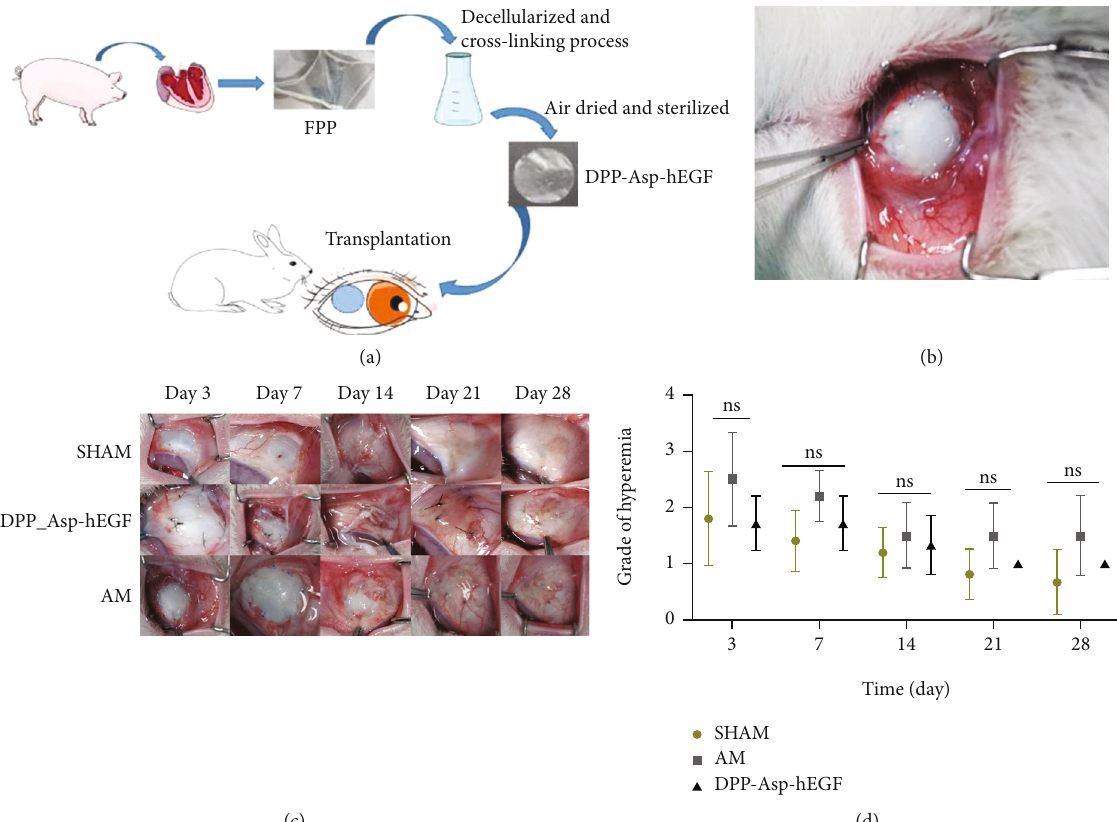
Figure 5: Clinical fi ndings in rabbit conjunctival defect model. The surgical procedure (a). Sca ff old transplantation on the day of surgery (b). Gross views of clinical signs at di ff erent points in time (c). A line graph showing the variation in the grade of hyperemia in each group at the di ff erent time points (d). ns=nonsigni fi